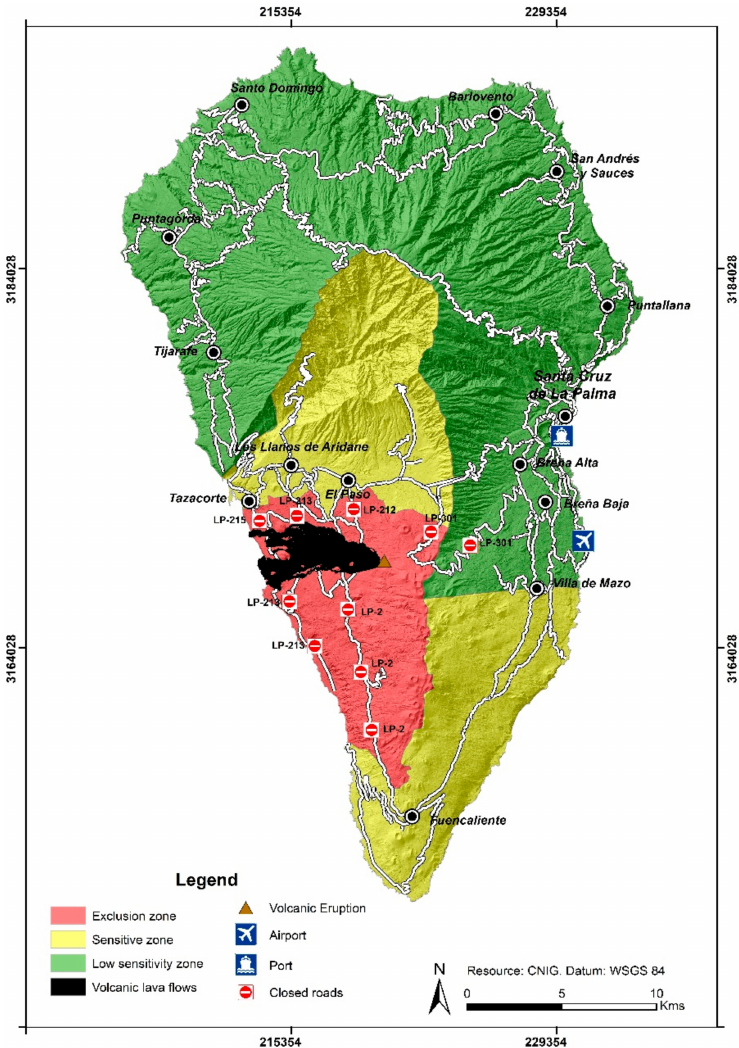
Figure 9. La Palma touristic map during eruption 2021. Source: CIT Tedote-Asdetur La Palma and Grafcan.